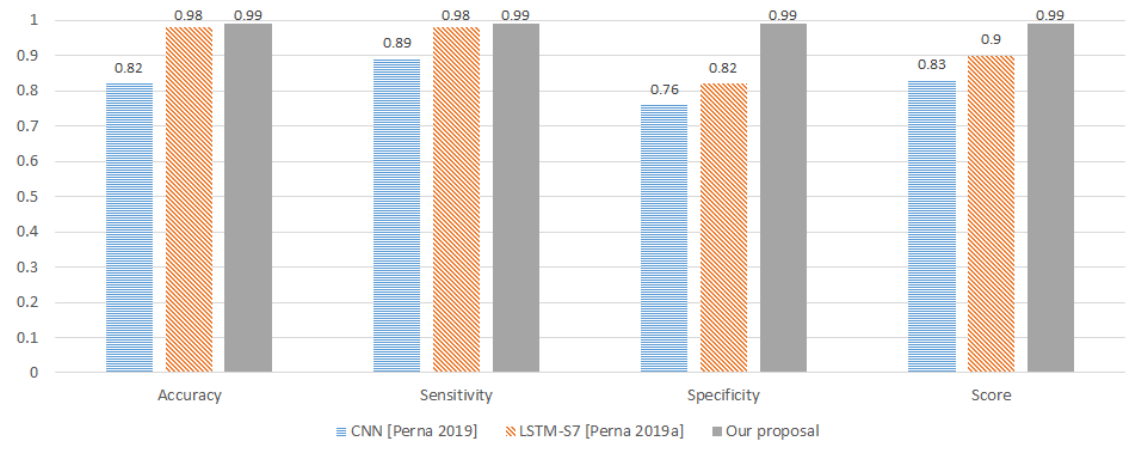
Figure 8. Comparative between our proposal method and the best results on the state-of-the-art using (International Conference on Biomedical and Health Informatics (ICBHI) dataset.